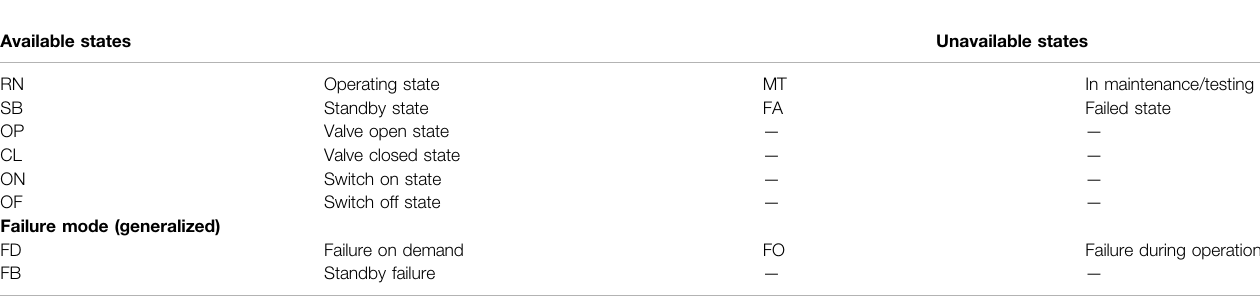
Table A1 | Classi fi cation of equipment state and failure events in RORMT.